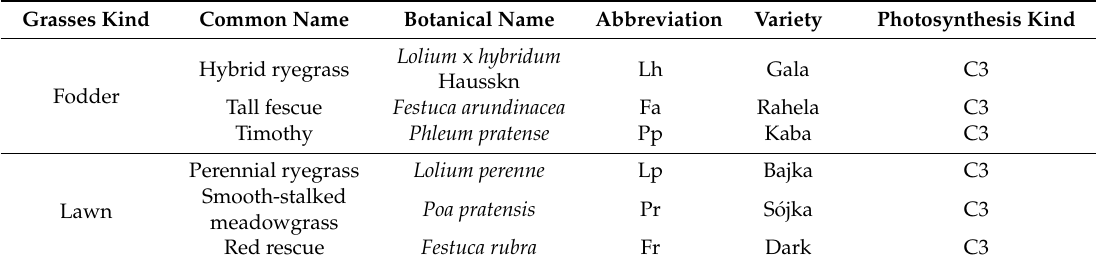
Table 2. Characteristics of grasses used in the